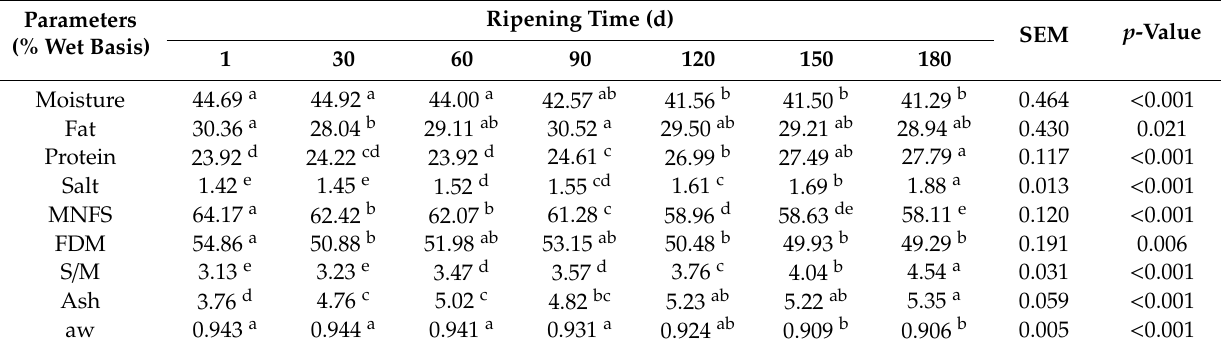
Table 2. Physicochemical properties of Mexican Manchego-style cheese made from Pelibuey ewes milk throughout ripening.